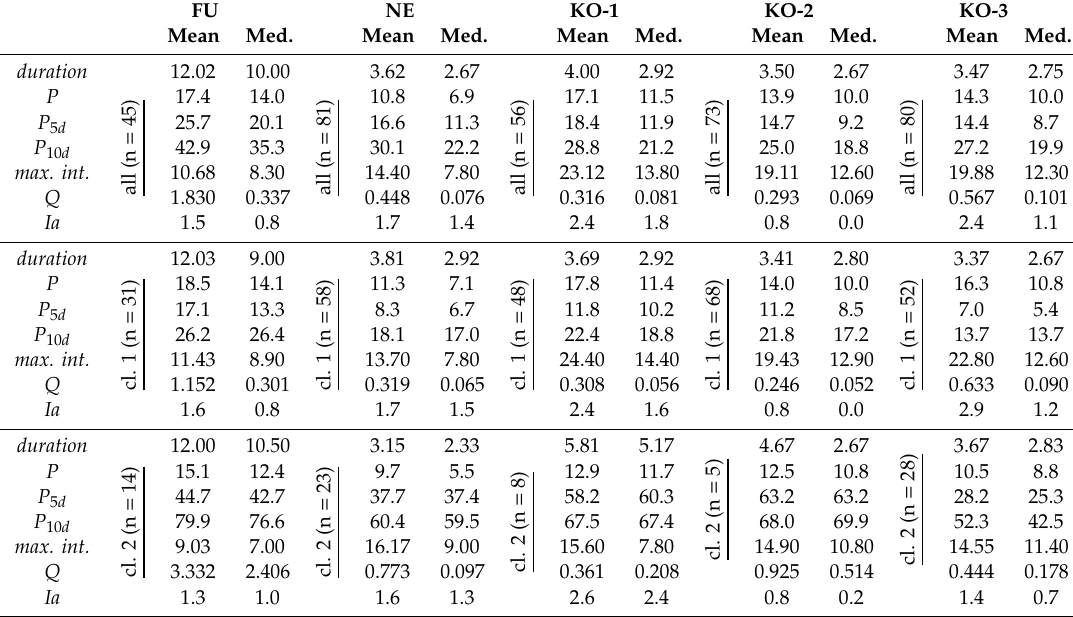
Table 5. Mean and median values of events’ parameters (duration (h), P (mm), P 5 d (mm), P 10 d (mm), max. int. (mm / h), Q (mm), Ia (mm)) in the delimited clusters for the experimental